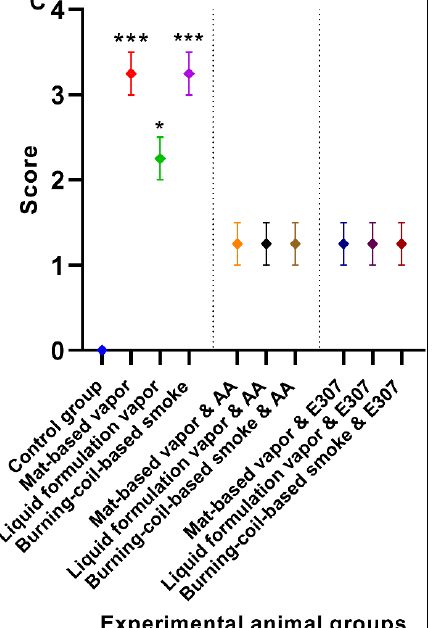
Figure 11. Effects of ascorbic acid (AA) and α -tocopherol (E307) on pyrethroid-induced toxicity in the brain of the animals with the degeneration of nervous tissue ( A ), lack of eosin uptake ( B ), and decrease in the number of neurons ( C ). Values are expressed as mean ± S.E. The Kruskal–Wallis non-parametric test was used for group differences and Dunnett’s corrections of the significance level for multiple comparisons were performed. The significance levels ( p -values) using a Dunnett’s corrections for all the variables were as follows: graph ( A ): **— p < 0.002 vs. the control group, while the letters a and c denote p = 0.03 compared to the animals exposed to mat-based vapor and burning-coil-based smoke; graph ( B ): ****— p < 0.0001 vs. the control group, while the letter a denotes p = 0.02 compared to animals exposed to mat-based vapor; graph ( C ): *— p = 0.03 and ***— p < 0.001 vs. the control group.